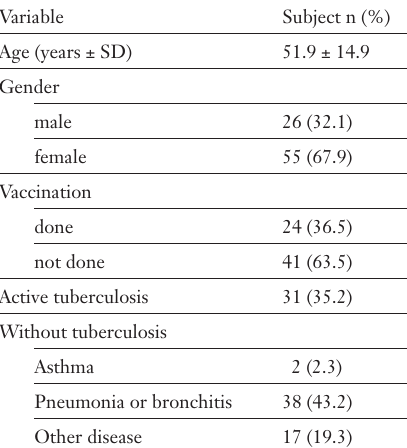
Characteristics of patients suspected of having pulmonary tuberculosis.